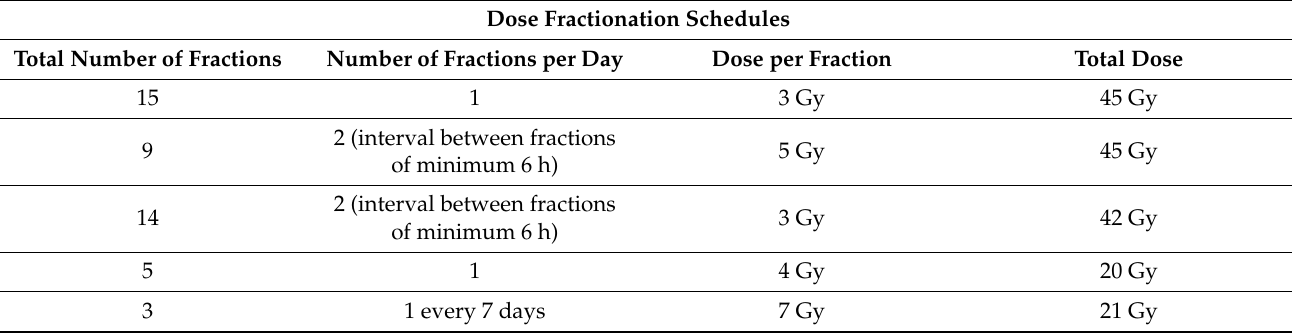
Table 2. Dose fractionation schedules applied in the treatment of all patients. Dose Fractionation Schedules